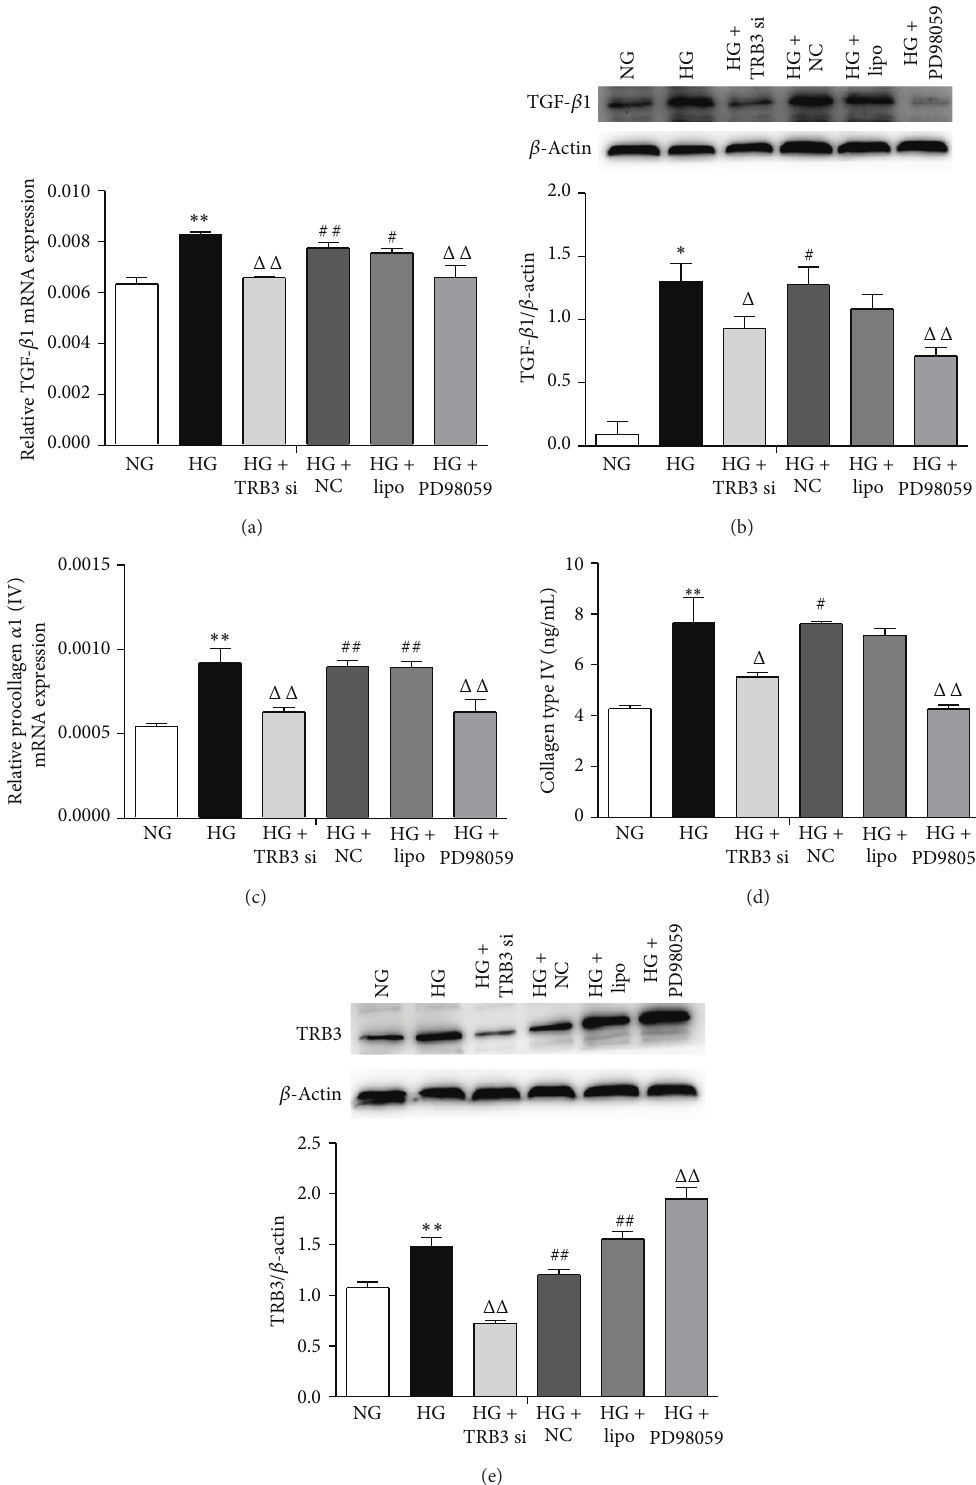
Figure 7: Effect of silencing TRB3 protein or blocking ERK1/2 MAPK pathway by a specific ERK inhibitor (PD98059, 10 𝜇 mol/L) on HG induction of TGF- 𝛽 1, collagen type IV, and TRB3 level in MMCs. (a) and (b) mRNA level of TGF- 𝛽 1 at 12h and protein level at 48 h; (c) and (d) mRNA level of collagen type IV at 12 h and protein level at 48h. MMCs were stimulated with NG or HG after blockade of TRB3 with TRB3 siRNA. (e) Protein expression of TRB3 at 48 h. Data are mean ± SEM. ∗ 𝑃 < 0.05 , ∗∗ 𝑃 < 0.01 versus NG; Δ 𝑃 < 0.05 , ΔΔ 𝑃 < 0.01 versus HG; # 𝑃 < 0.05 , ## 𝑃 < 0.01 versus NG + TRB3